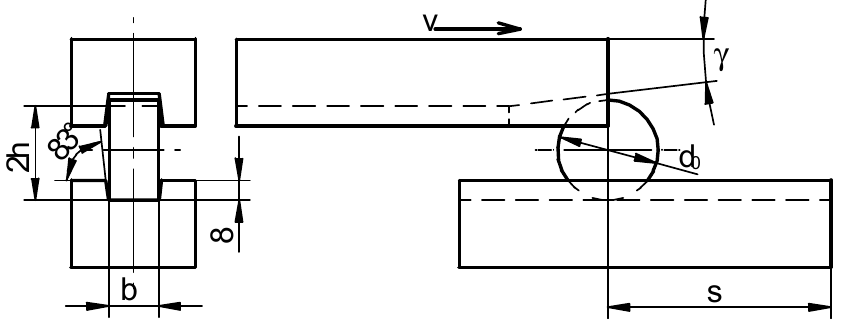
Figure 8. Scheme of the calibrating test of the damage function conducted using the method of rotational compression in a channel.